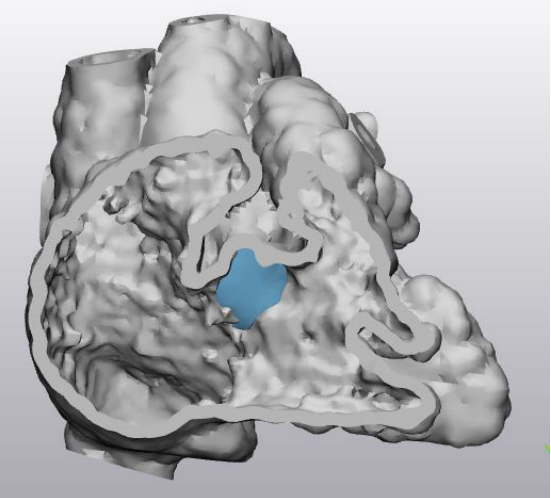
Figure 2. A transected digital heart model demonstrating a ventricular septal defect with a virtual patch (in blue) over the defect.